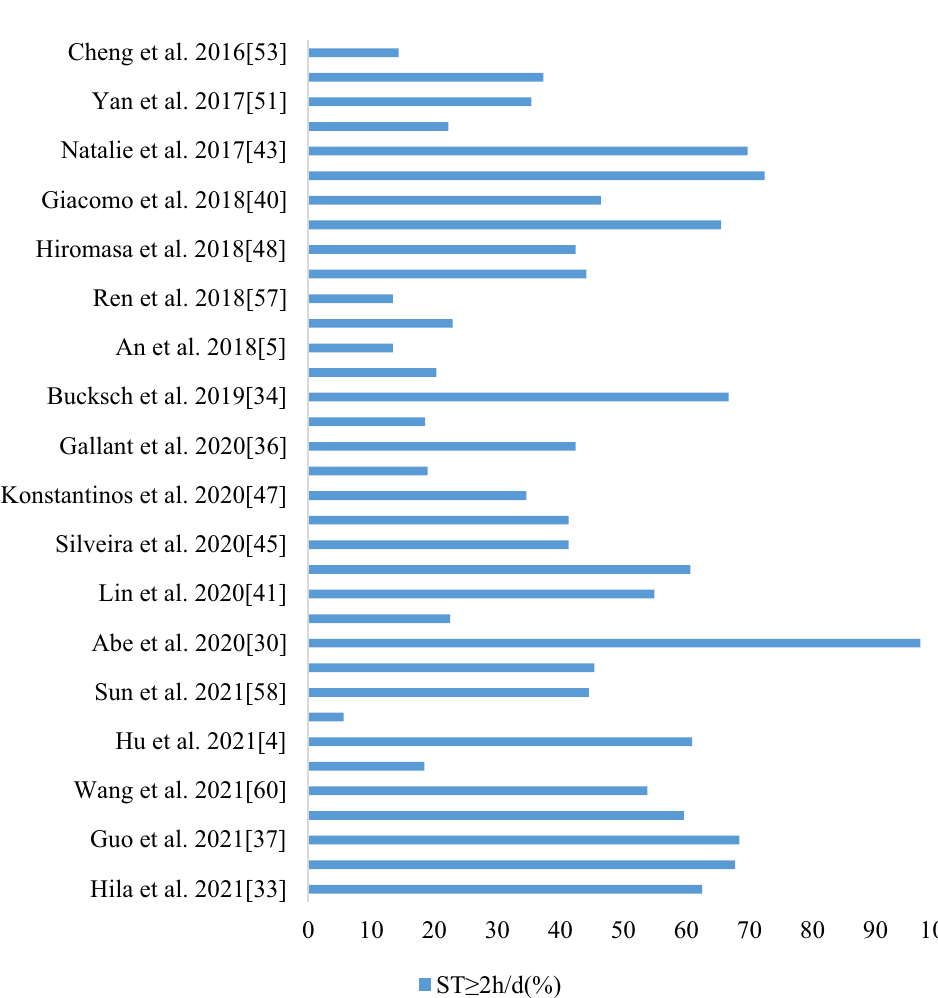
Fig. 4 Screen time of 6–14 year old school children (classification